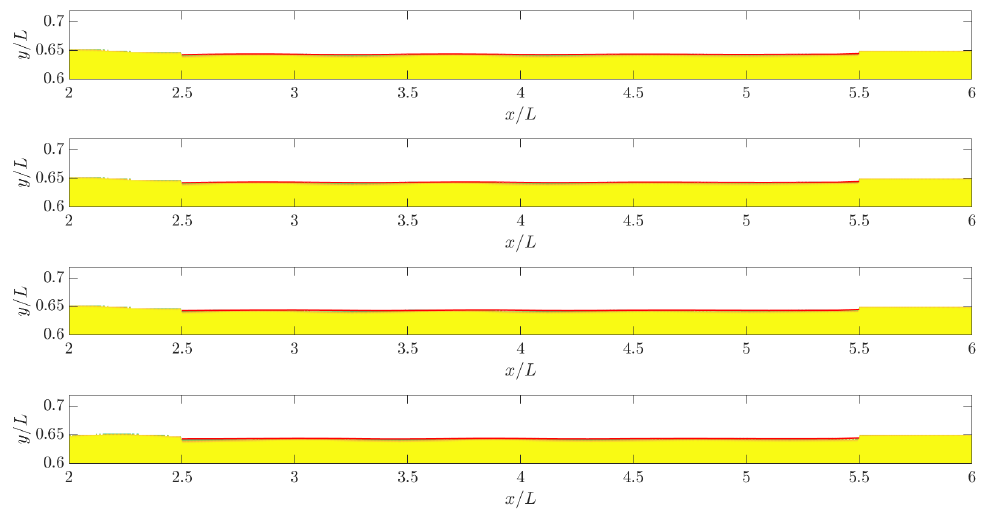
Figure 8. Snapshots presenting the water surface elevation profile around the viscoelastic cover at different time steps. The red curve displays the solid cover interacting with water waves.